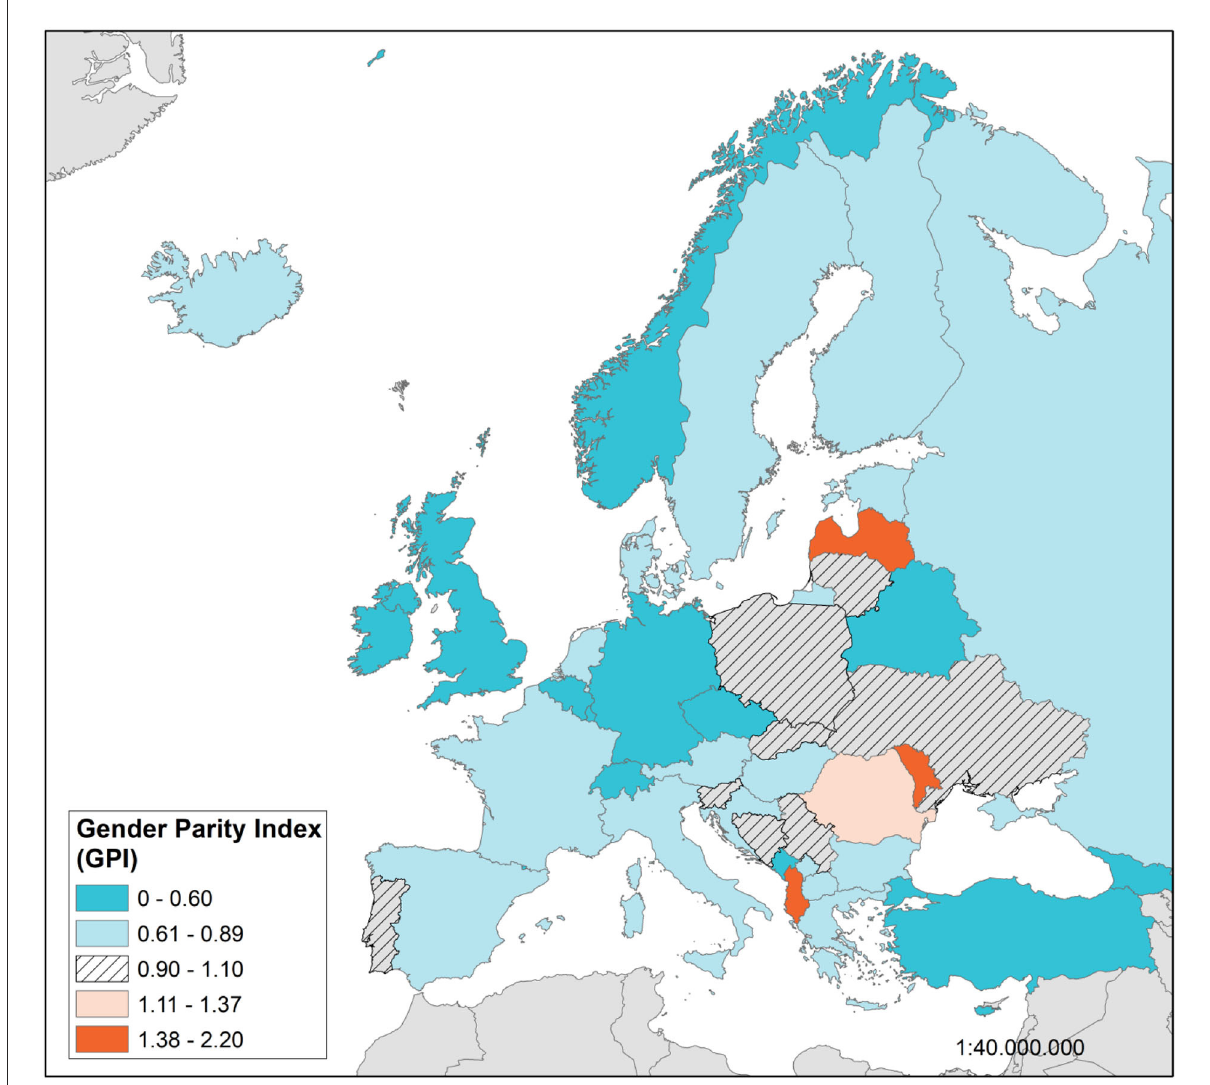
FIGURE1 Adapted Gender Parity Index (GPI) by countries (0.90–1.10 gender parity; < 0.90 in favor of men; > 1.10 in favor of women). Only European countries are displayed on the map, although the publications’ co-authors may be from outside